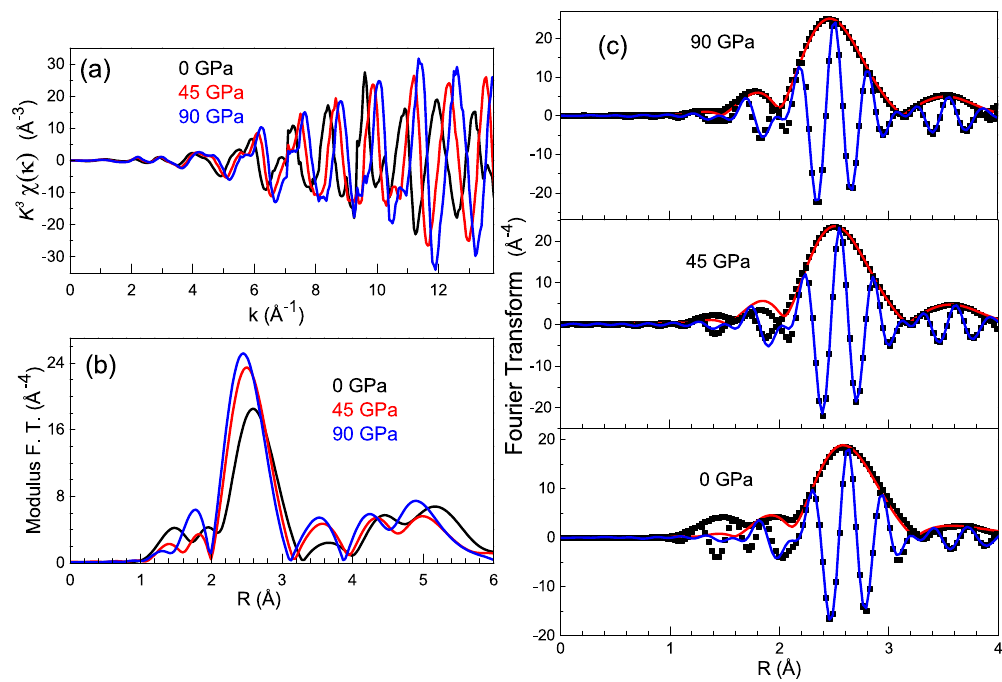
Figure 4. ( a ) k 3 χ (k) EXAFS signals and ( b ) Fourier Transform at the Ir L 3 -edge at 0 GPa (black curve), at 45 GPa (red curve) and at 90 GPa (blue curve). ( c ) The Fourier transformed k 3 χ (k) EXAFS signals at 0 GPa, at 45 GPa and at 90 GPa are represented in black squares. The finest fits of the modulus and imaginary parts are shown in red and blue line,